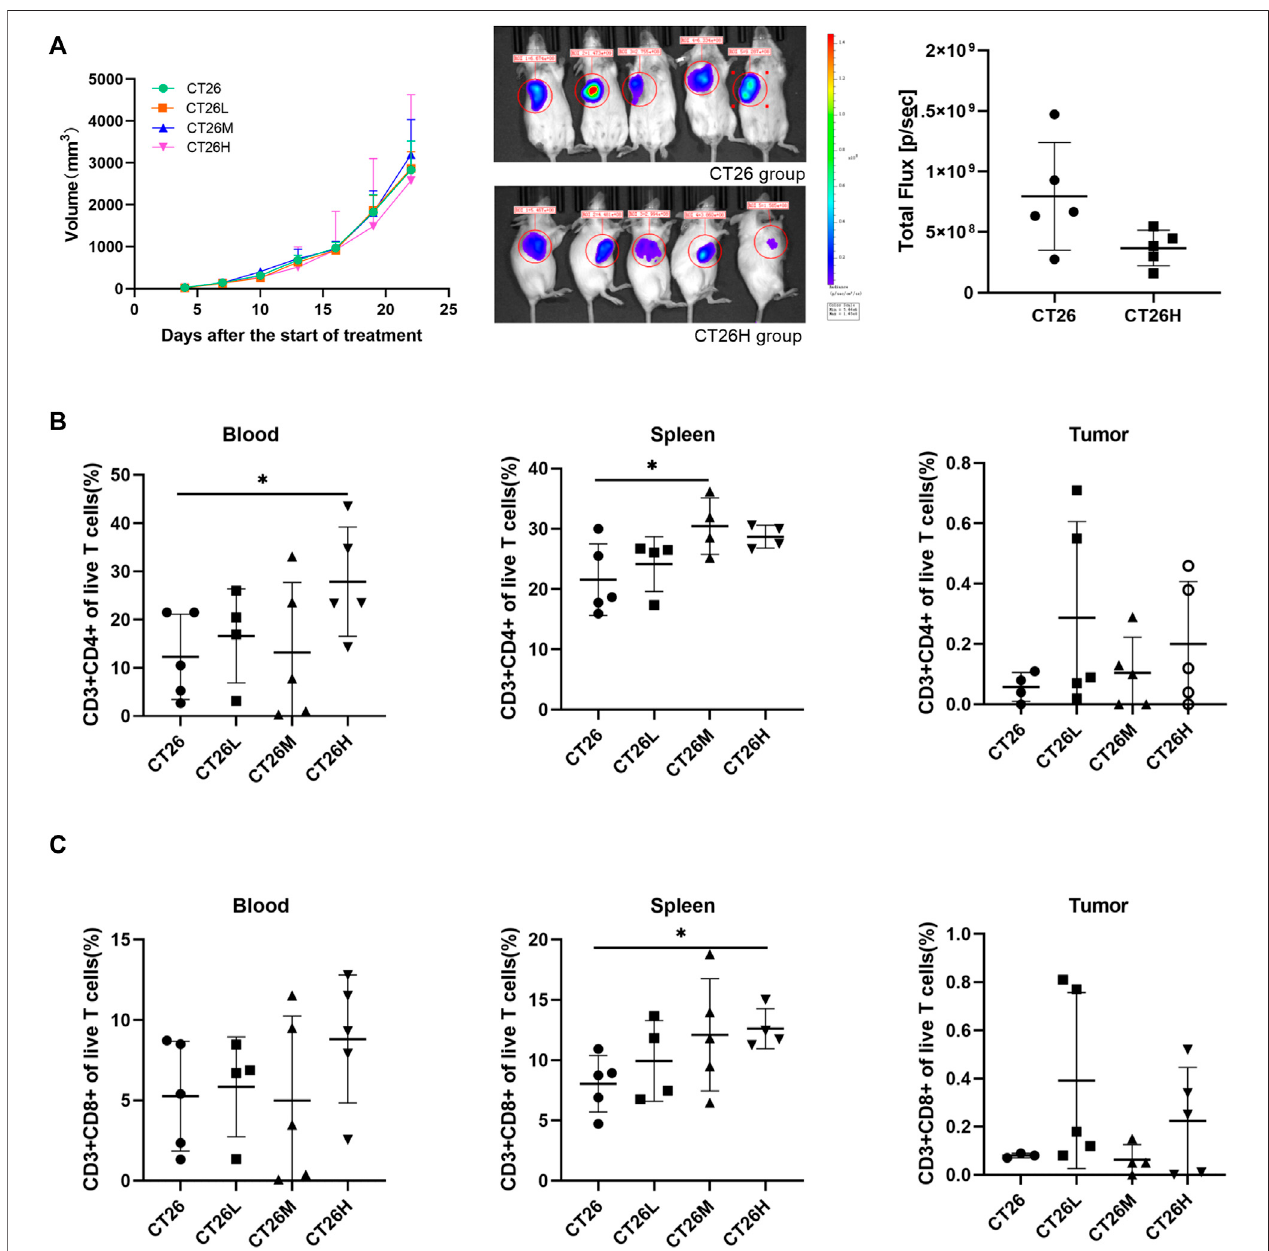
FIGURE 1 | Tumor volume and percentage of lymphocytes among the CT26 group and FFCT-treated groups. (A) Tumor volume among the CT26 group and FFCT-treated groups( p > 0.05).Percentage ofCD3 + CD4 + (B) and CD3 + CD8 + Tcells (C) intheblood, spleen,and tumor tissue oftheCT26 tumor-bearing mice treated with FFCT. * represents p <